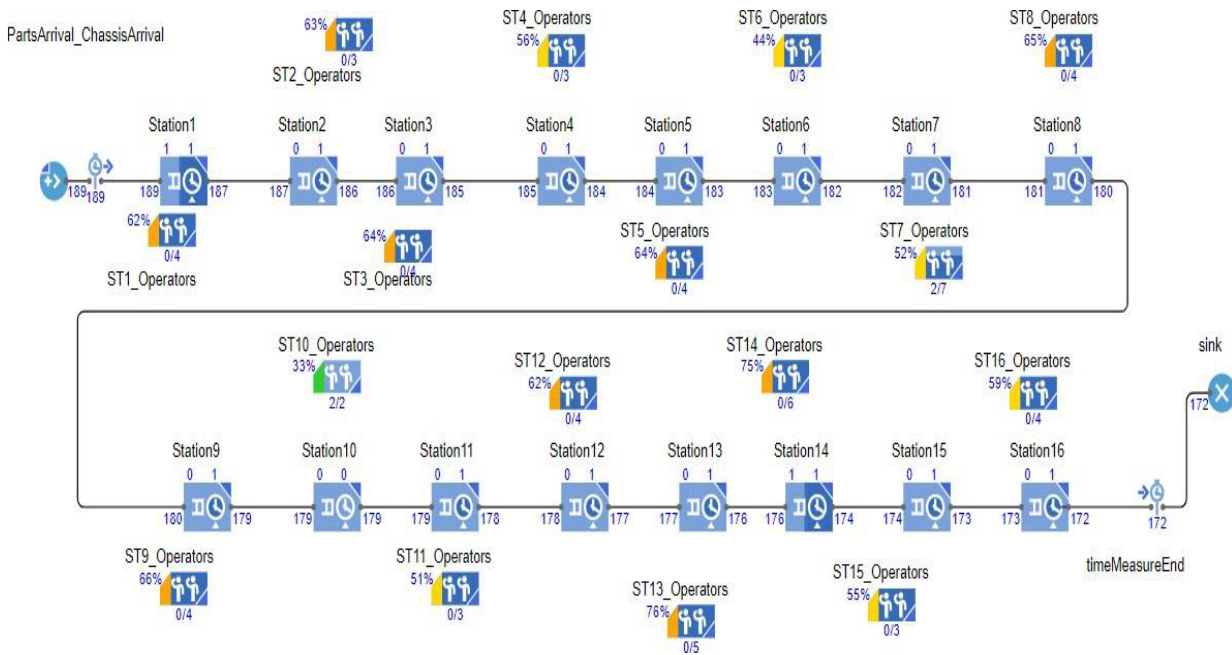
Figure 6. VSM of the productivity improvement through SVSM.